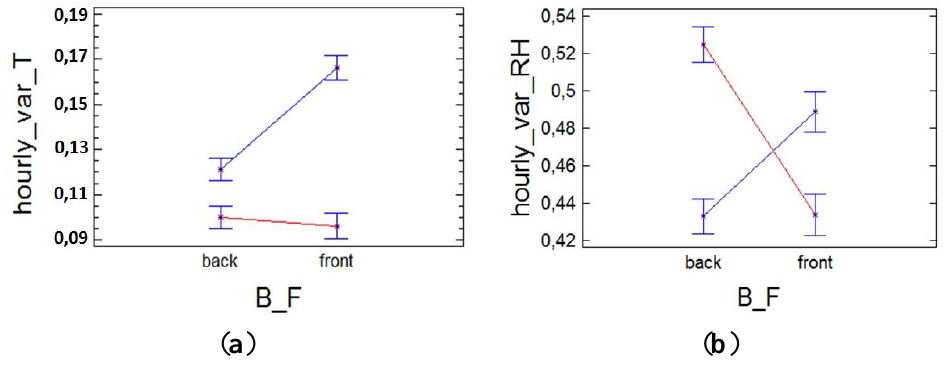
Figure 4. Interaction plot of the factors orientation (B/F) and season (cold = blue, warm = red), for the ANOVA analysis of the hourly variation of ( a ) temperature, ( b )